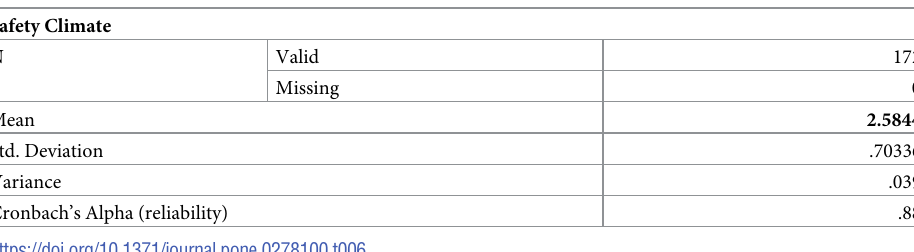
Table 6. Overall mean